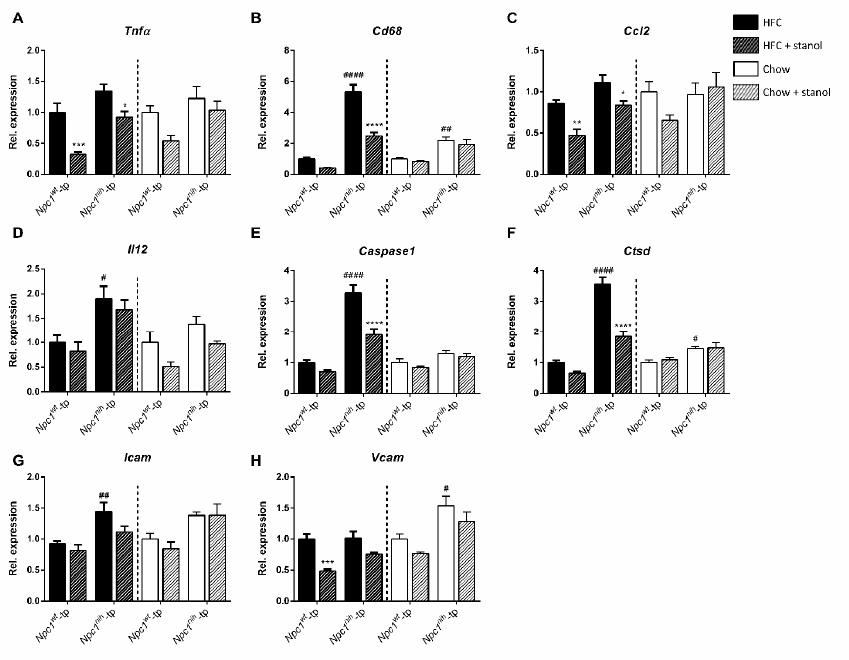
Figure 6. Hepatic inflammation-related gene expression: HFC and chow diets. Hepatic gene expression of inflammatory markers ( A ) Tnf- α , ( B ) Cd68 , ( C ) Ccl2 , ( D ) Il12 , ( E ) Caspase1 , ( F ) Ctsd , ( G ) Icam and ( H ) Vcam . n = 6–8 mice per group for gene expression analyses. All error bars represent standard error of the mean. Statistical significance is indicated as fol- lows: Npc1 nih -tp mice on a HFC or chow diet vs. Npc1 wt -tp mice on a HFC or chow diet (# p ≤ 0.05; ## p < 0.01; #### p < 0.0001); Npc1 wt -tp or Npc1 nih -tp on a HFC or chow diet vs. Npc1 wt - tp or Npc1 nih - tp mice on a plant stanol-enriched HFC or chow diet (* p ≤ 0.05; ** p < 0.01; *** p < 0.001; **** p < 0.0001).